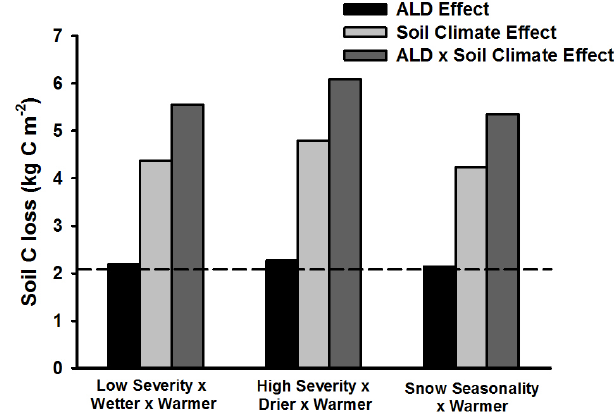
Fig. 7. The effect of single climate factors (air temperature, soil moisture, and snow depth) or fire severity on soil C storage. Soil C loss or gain was calculated as the difference in total soil C stocks in top 2m of soil between model years 6500 and 7000yr (or ap- proximately 3 fire cycles after step-change in climate/fire). To cal- culate the active layer depth (ALD) effect, we used only modified the relationship between ALD and organic horizon thickness (from Table 4) for each scenario in the Fire-C model. To calculate the soil climate effect, we modified decomposition constants within the Fire-C model to reflect future changes in soil temperature (Fig. 5) and/or soil moisture (Table 1). To calculate the ALD+soil climate effect, we modified both the ALD-OHT relationship and the de- composition constants within the Fire-C model. The dashed line represents total OC losses (ALD+soil climate) when present-day climate conditions (with no changes in snow, moisture or fire) were run for 3 fire cycles.